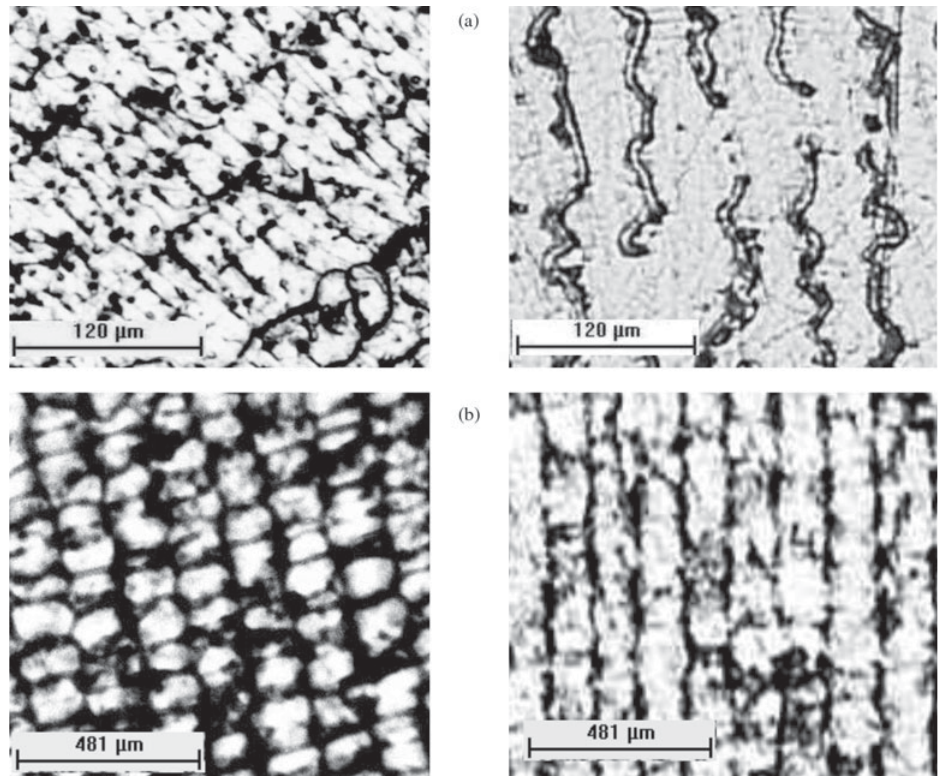
Figure 7. Resulting microstructure for Sn-2.5wt%Pb alloy: a) celullar/dendritic P = 5 mm, λ cellular P = 50 mm, λ